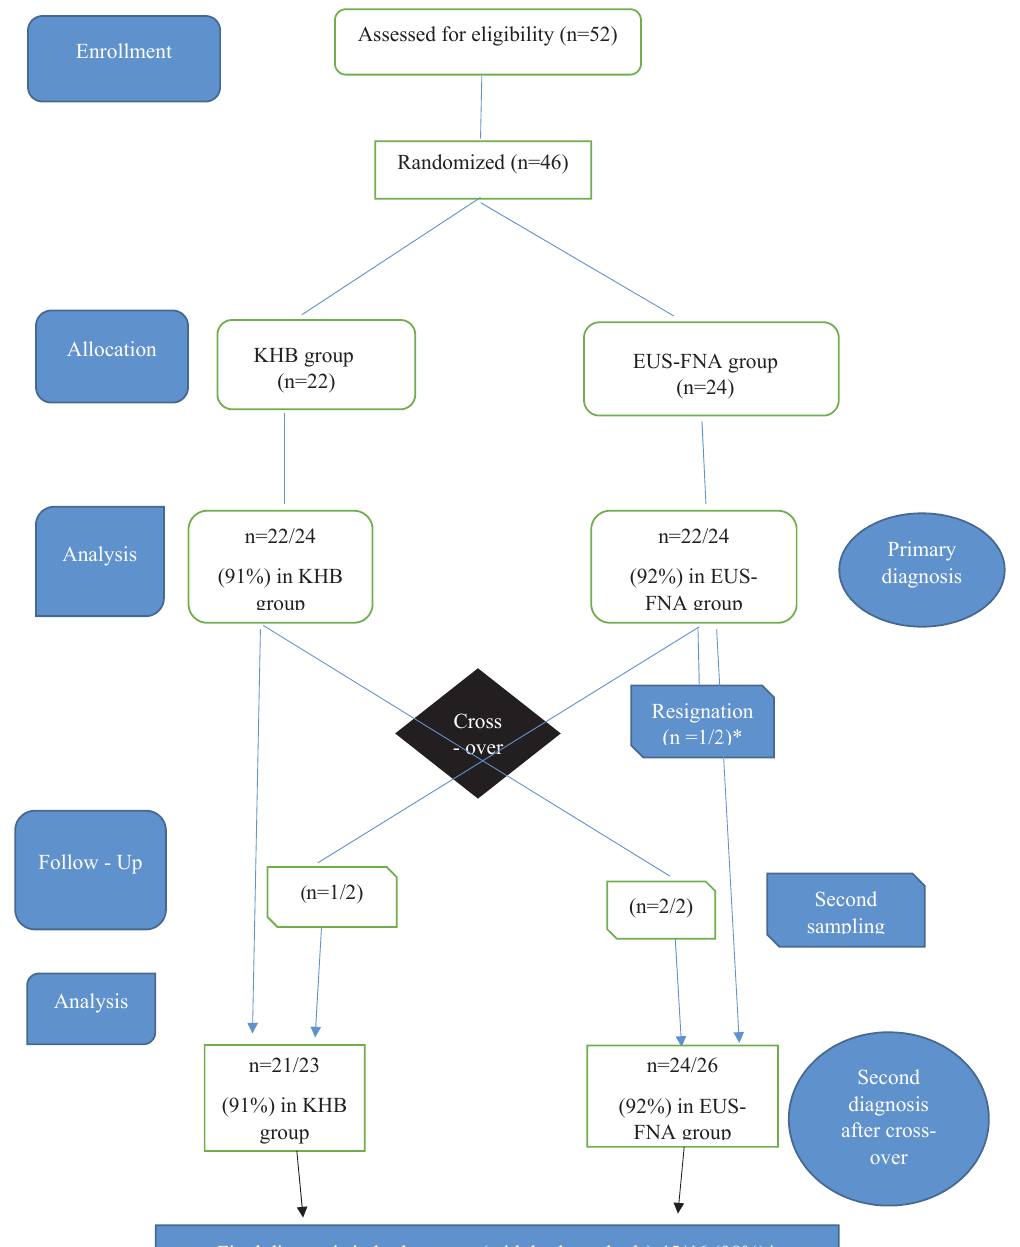
Fig. 5. Study flow